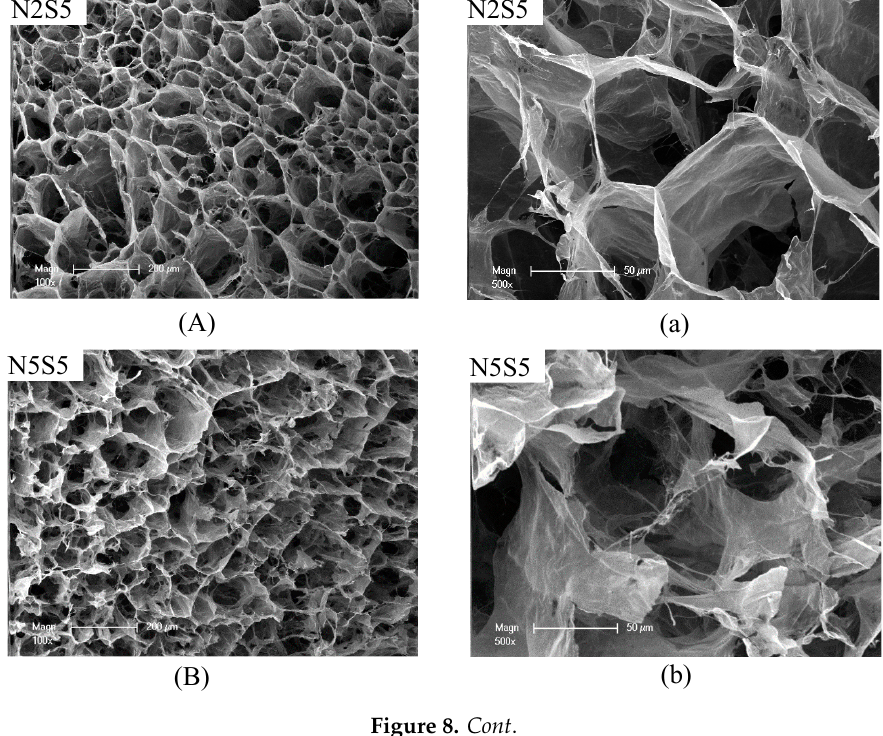
Figure 7. ( A ): macro figure of aerogel; ( B ): macro figure of nanocellulose aerogels prepared under; different processing conditions (N2S5: 2 wt% NaOH and 5 min sonication, N5S5: 5 wt% NaOH and 5 min sonication, N2S10: 2 wt% NaOH and 10 min sonication, N5S10: 5 wt% NaOH and 10 min